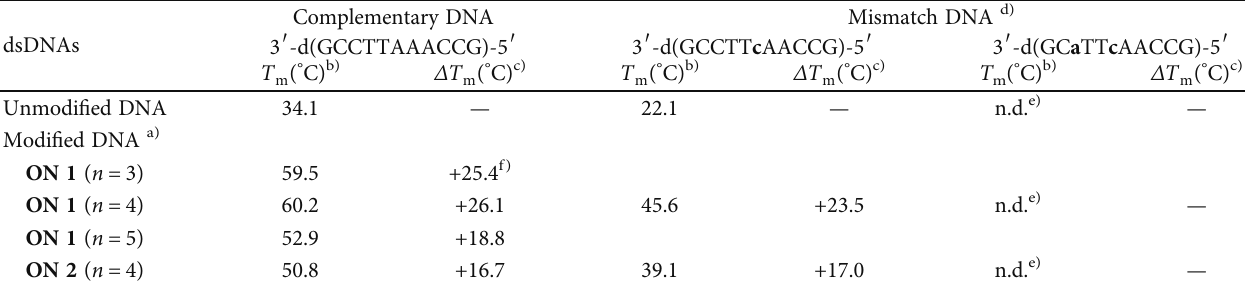
fi ed dsDNAs and respective Δ T Table 1: T m values of modi